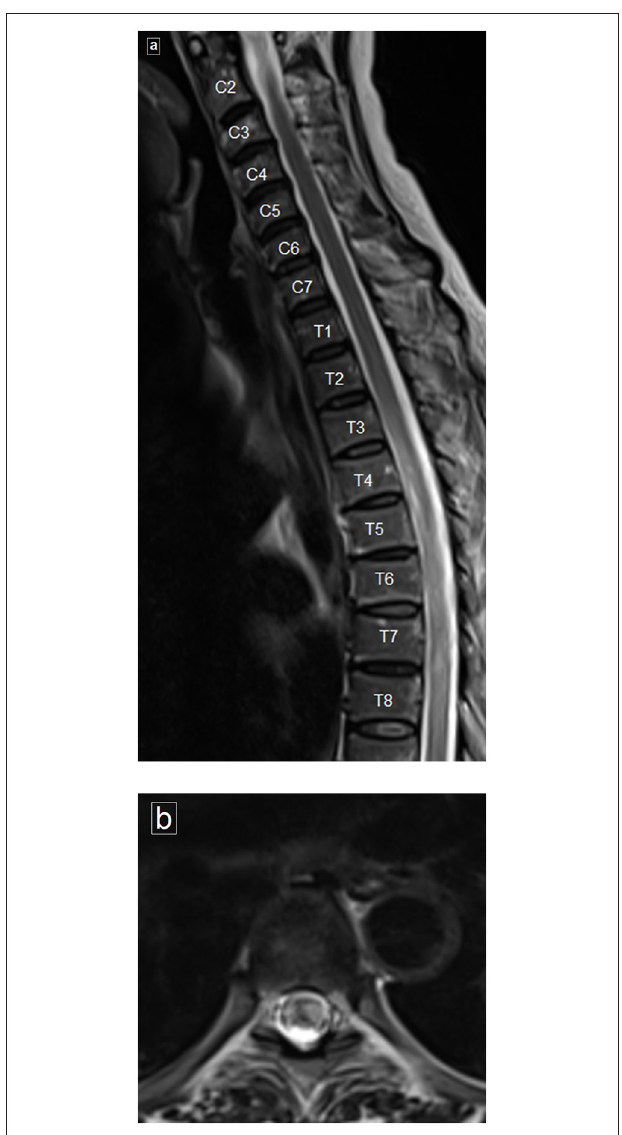
FIGURE 1 | Magnetic resonance imaging (MRI) of spine. (a) Sagittal T2-weighted image of the cervical and dorsal spine reveals poorly delineated long segment of hyperintense signal, clearly evident from T4 to T8. (b) Axial T2-weighted image showing the hyperintense signal involving more than two thirds of the cross-sectional area of the